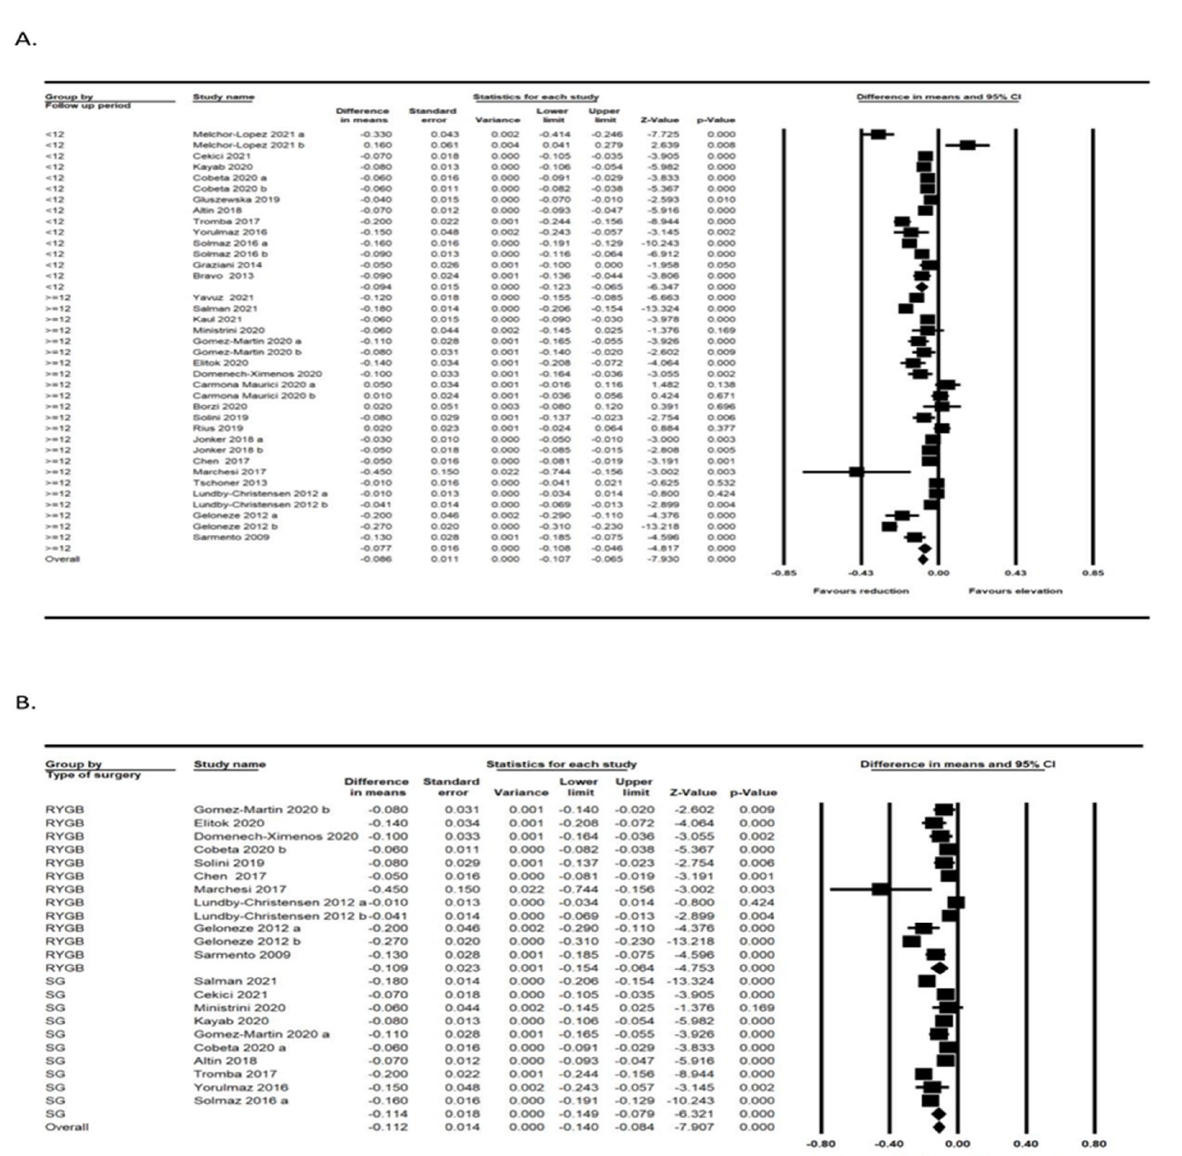
Figure 4. Subgroup analysis based on the follow-up period [32–37,39–43,45–60] ( A ) and type of surgery [33,37–42,45,49,50,52–54,58–60] ( B ).